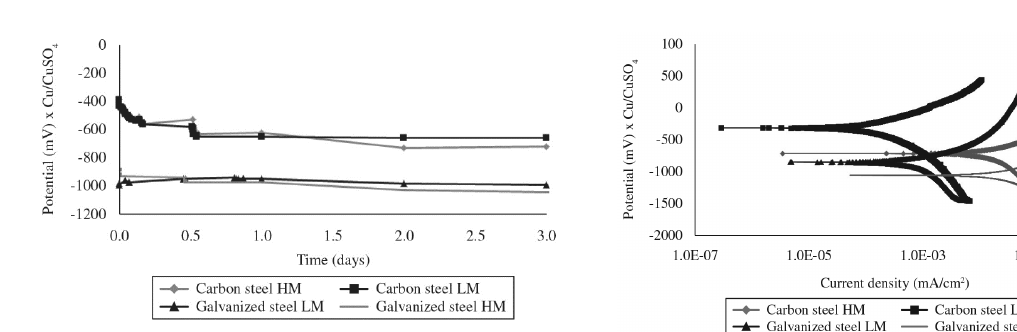
Figure 3. Soil moisture monitoring (HM: High moisture e LM: Low moisture).